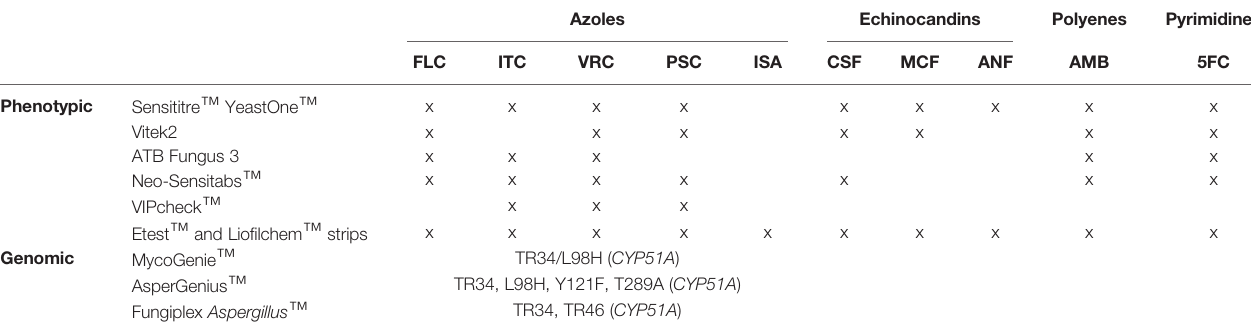
TABLE 2 | Antifungal agents tested and mutations detected by commercial antifungal susceptibility testing